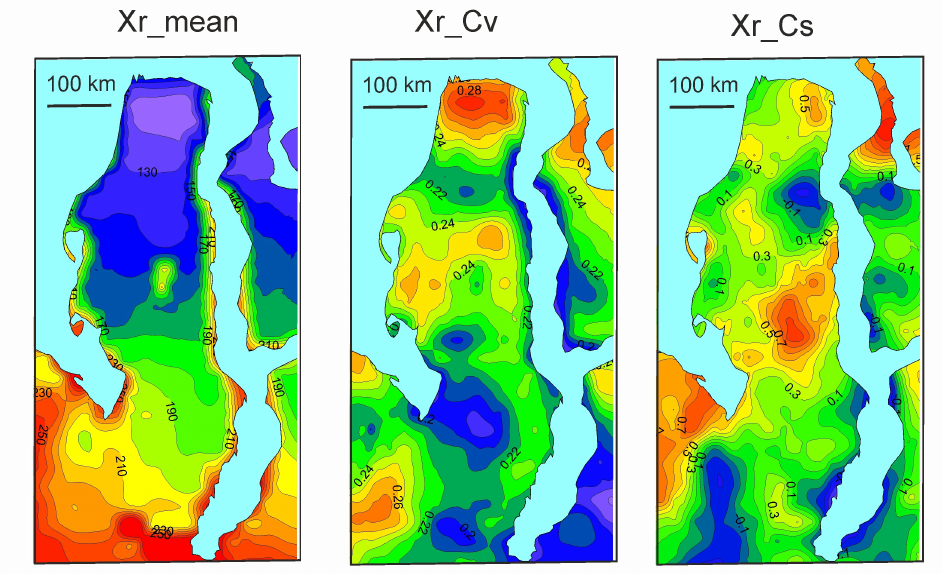
Figure 25. Spatial distributions of mean surface runo ff X r , its temporal variability C v and skewness C s for the period of summer rains on the Yamal peninsula.